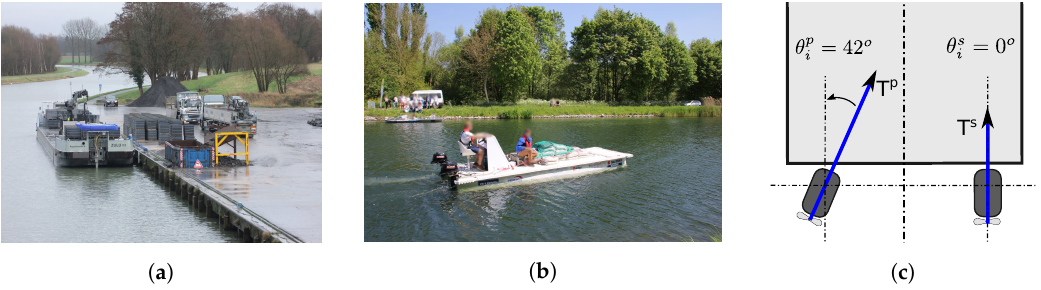
Figure 4. The pallet shuttle barge: ( a ) a real barge’s handling cargo at a dock [40], ( b ) the KU Leuven scale model named Maverick, and ( c ) the propulsion system of Maverick consisting of two outboard motors which can rotate between [ − 42,42 ] ° and which can have different thrust force magnitudes.